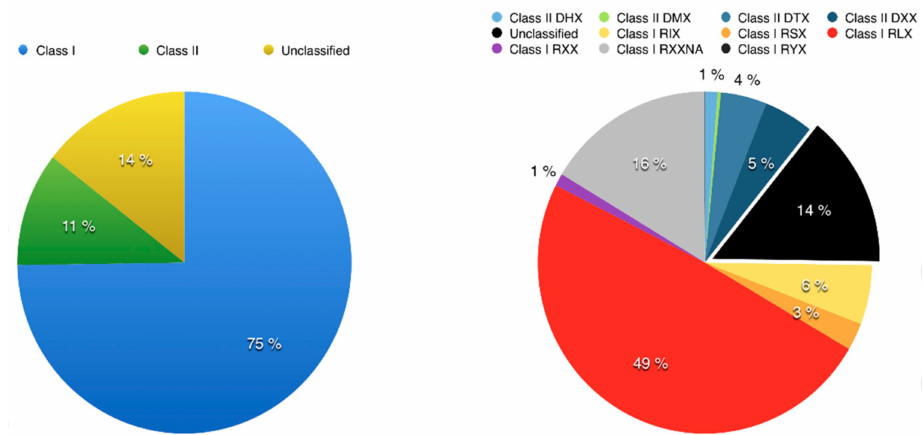
Figure 4. Transposable element abundance found in the pineapple genome. Classification of Transposable Elements (TEs) (left) and a detailed composition using the acronym classification developed by Wicker [8] (right) are presented: DHX (Helitron), DMX (Maverick), DTX (TIR Transposon), DXX (MITE), RIX (LINE), RLX (LTR retrotransposon), RSX (SINE), RXX (unclassified or non-autonomous retrotransposons), RYX (DIRS).